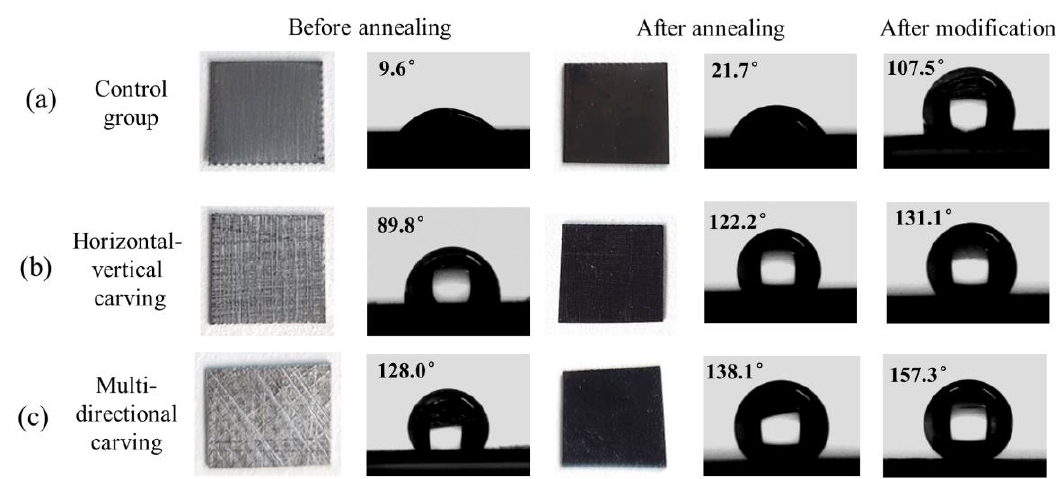
Figure 1. Digital photos and CA results of ( a ) ordinary iron, iron samples treated by ( b ) horizontal– vertical carving and ( c ) multi-directional carving under different treatment including annealing and surface modification.